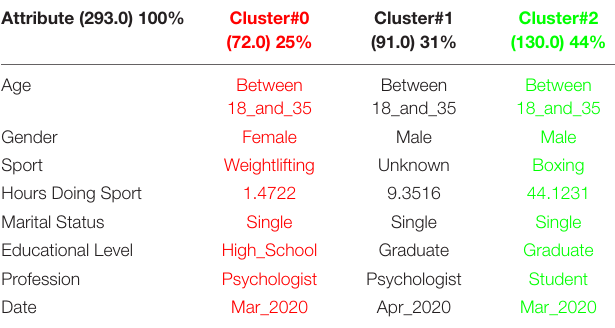
TABLE 12 | 3 clusters MBI analysis for March to May 2020.